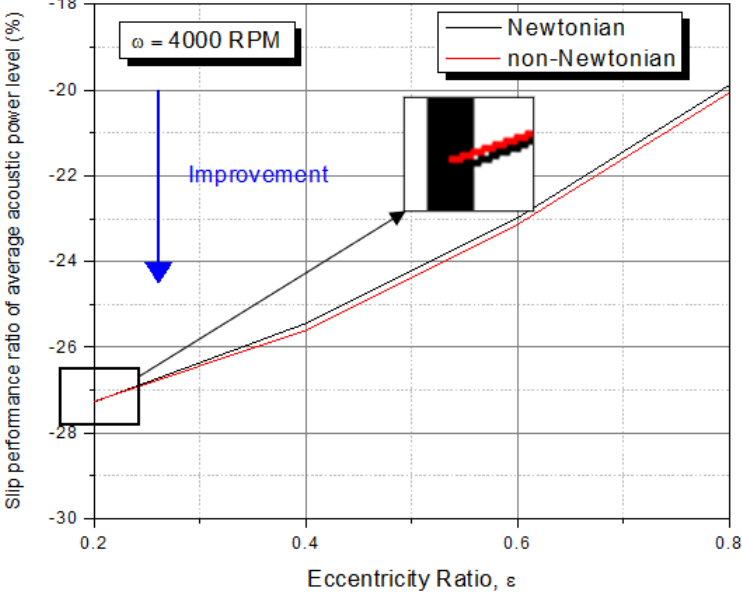
Figure 15. Slip performance ratio of average acoustic power level P A for several eccentricity ratios for the case of Newtonian and non-Newtonian fluids ( SPR = sign indicates a performance improvement.